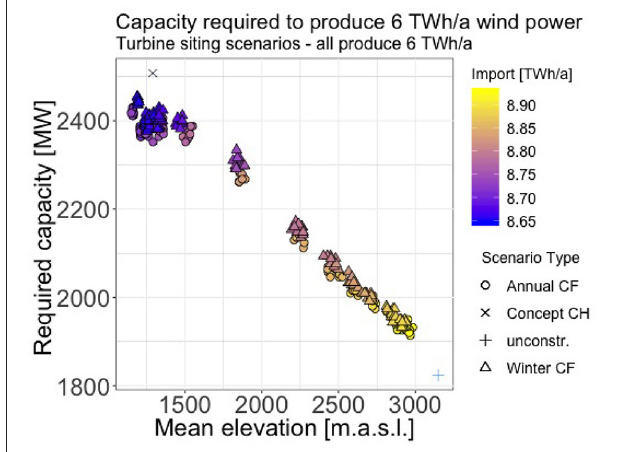
FIGURE 8 | The required capacity as function of the mean elevation of the locations where turbines are located in each scenario. Also included in this figure are a scenario based on the Swiss Wind Energy Concept Bundesamt für Raumentwicklung (2017) , “Concept CH,” as well as a scenario without constraints on elevation or locations (“unconstr”).